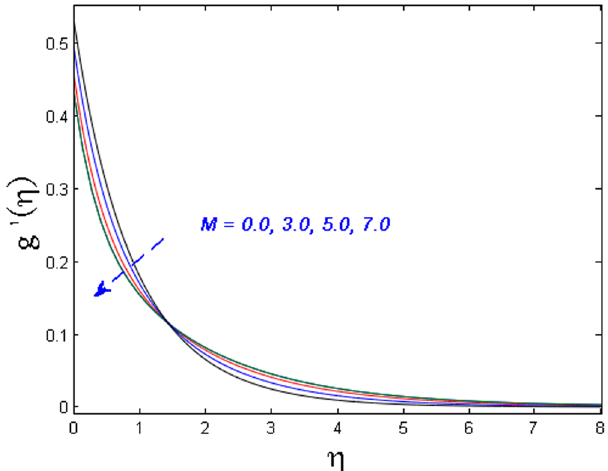
Figure 10. Effect of M on g ′ ( η ).